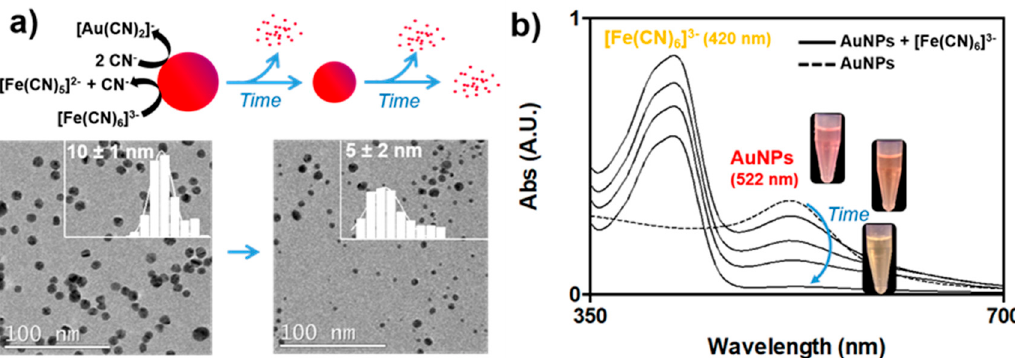
Figure 2. Ferricyanide dissociation by AuNPs. ( a ) Scheme representing ferricyanide dissociation by AuNPs, subsequent gold cyanidation and representative TEM images of AuNPs before and after reaction with 1 mM ferricyanide. Inset, size distribution histograms (the average size was obtained by counting at least 150 NPs). ( b ) Time evolution of the UV-vis spectra of AuNPs with ferricyanide (dashed line corresponds to untreated NPs). Inset, images showing the colour evolution of the AuNP suspension.